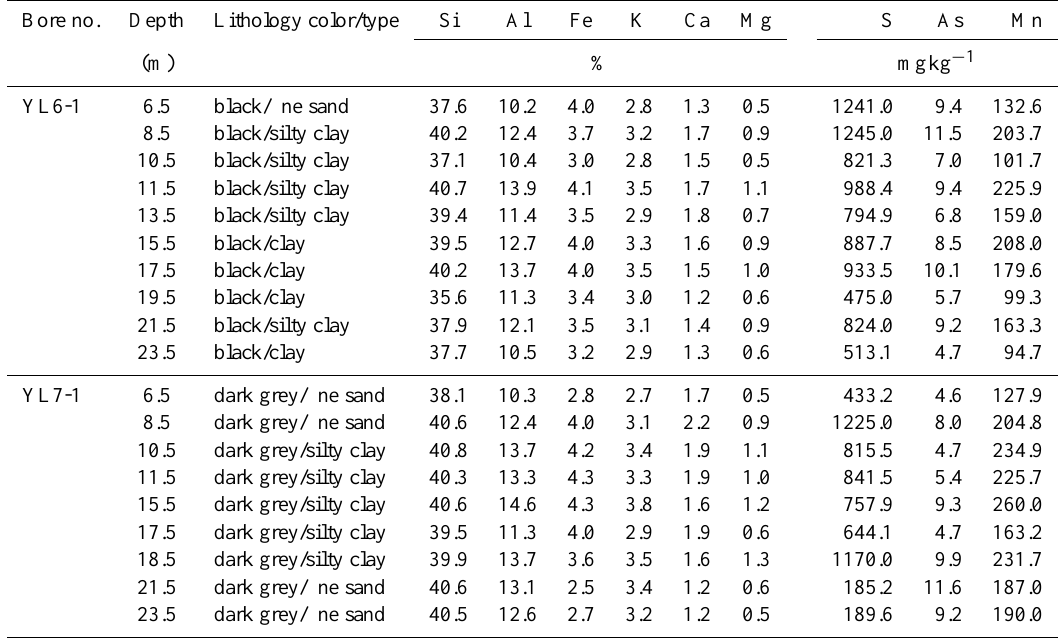
Table 2. Major elements (wt%), arsenic and manganese (mgkg − 1 ) contents in core samples. Bore no.